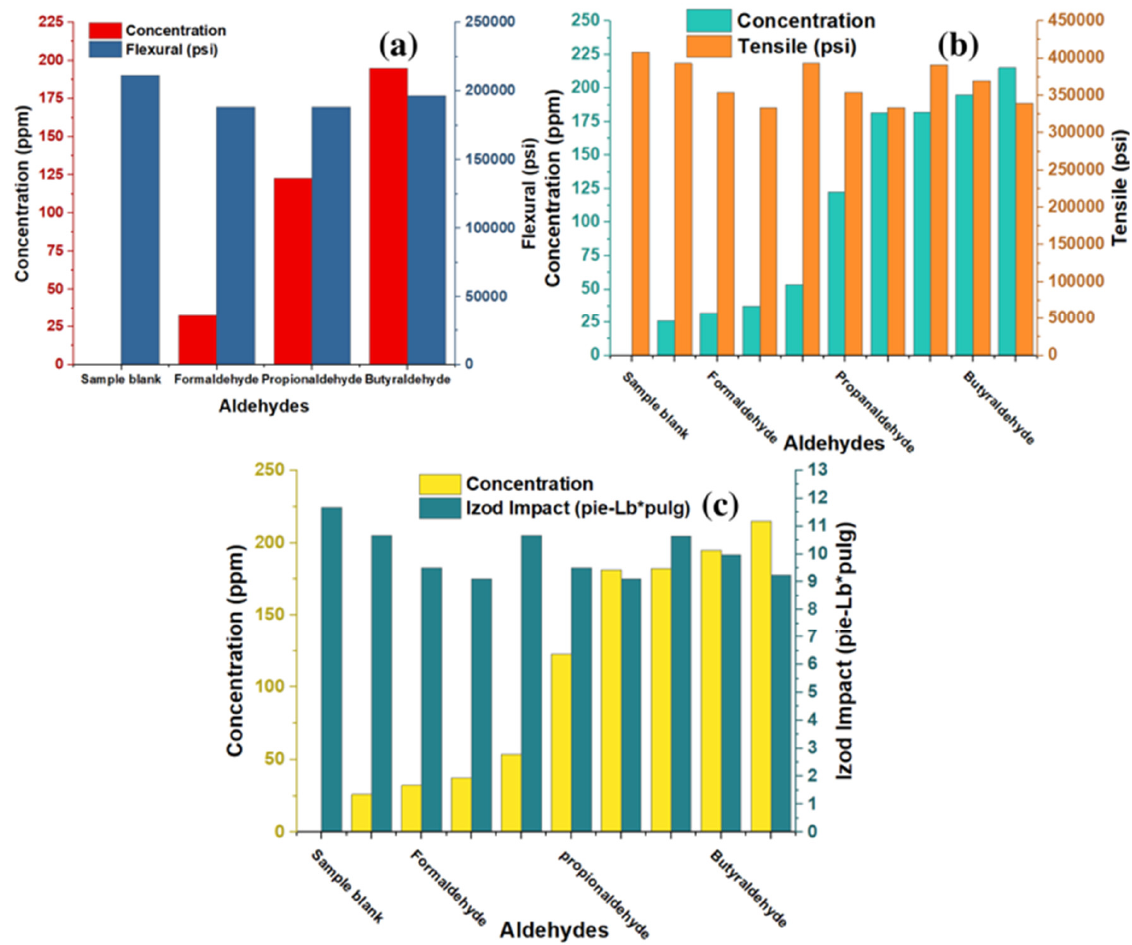
Figure 7. Effects of formaldehyde, propionaldehyde, and butyraldehyde on the random copolymer’s mechanical properties. Flexural ( a ), tensile ( b ) and Izod Impact ( c ).